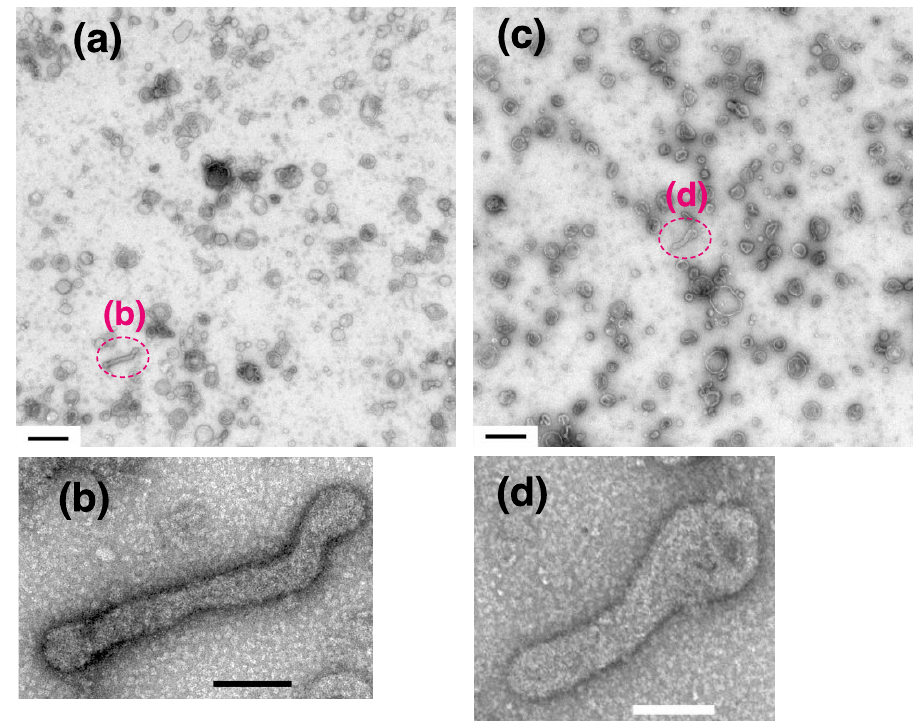
Figure 9. SR vesicles in the absence of ATP at 0 °C. The SR preparation was incubated in buffer containing 0.02 nM Ca 2+ ( a , b ) or 2 µM Ca 2+ ( c , d ). ( a , c ) Low magnification images. The vesicles did not agglomerate significantly in either buffer. ( b , d ) Higher magnification images of the annotated areas in the panels above. Round vesicles and crookedly elongated vesicles were observed, although tightly elongated vesicles were not imaged at all. Scales bars in ( a ) and ( c ): 0.5 µm. Scale bars in ( b ) and ( d ): 100 nm. Table 2. Number of elongated and round-types of vesicles, observed at 0.04 nM and 2.0 µM Ca 2+